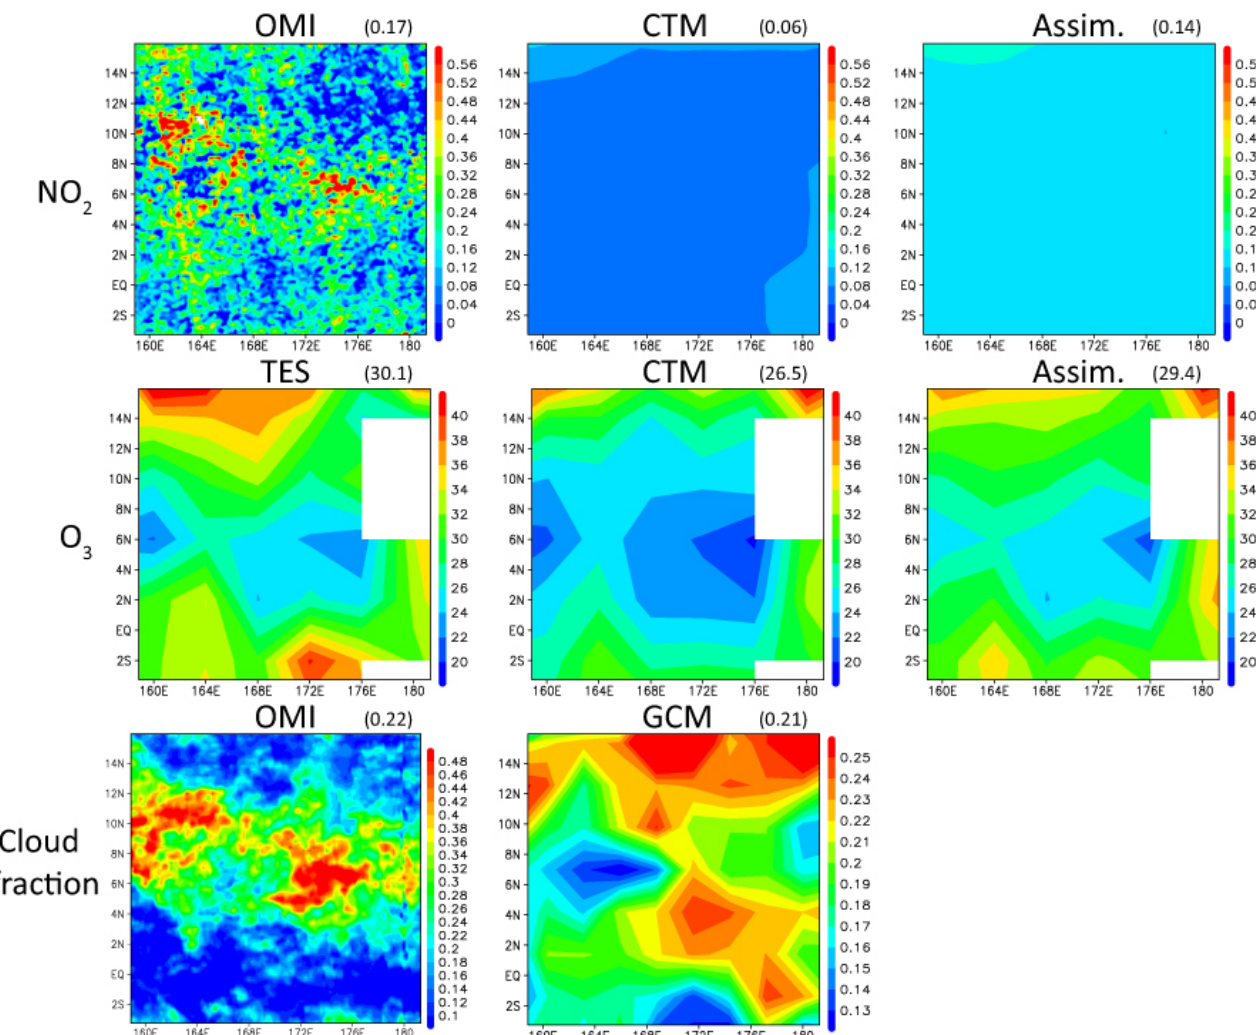
Fig. 11. Spatial distributions of tropospheric NO 2 column concentration (upper panels, 10 15 moleccm − 2 ), O 3 concentration at 300hPa (middle panels, in ppbv), and cloud fraction (lower panels) over the western Pacific. Each is averaged over 14–21 August 2007. For the NO 2 and O 3 concentrations, the results obtained from the OMI and TES satellite retrievals (left panels), the CTM simulation (center panels), and the data assimilation (right panels) are shown. For the cloud fraction, the results obtained from the OMI retrievals (left) and the GCM simulation (right) are shown. The numbers in brackets represent the regional mean value for each